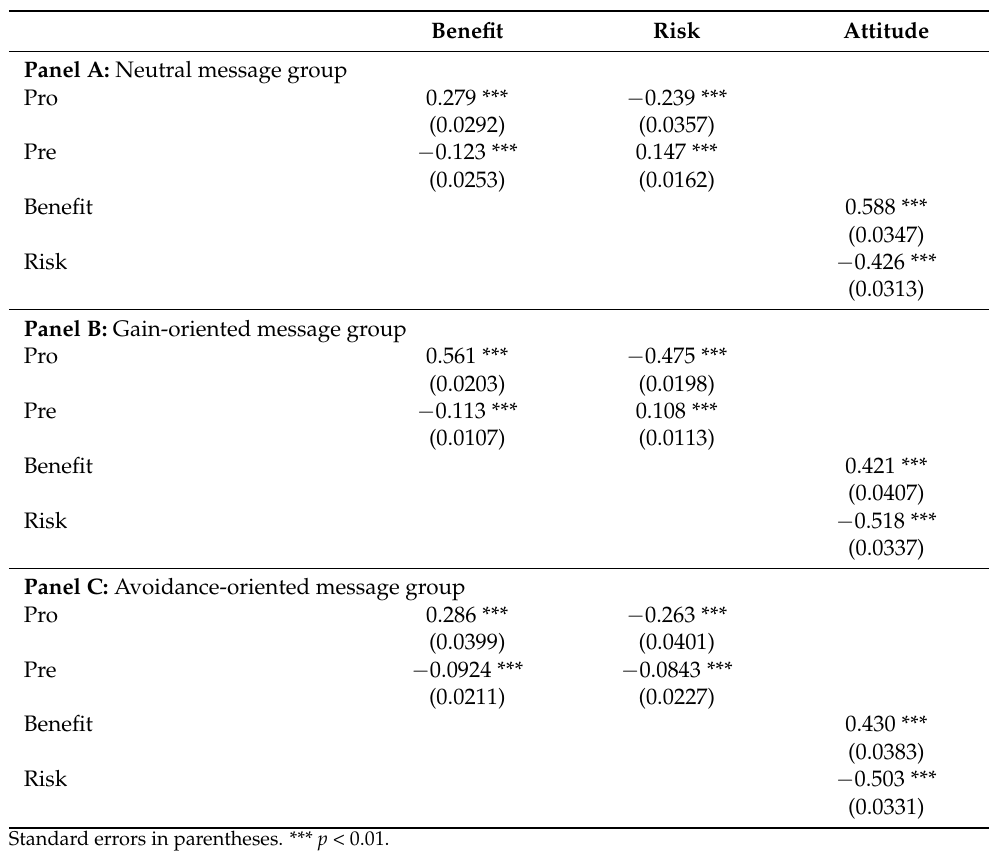
Table 2. The structural model of plant-based meat (standardized coefficients). Benefit